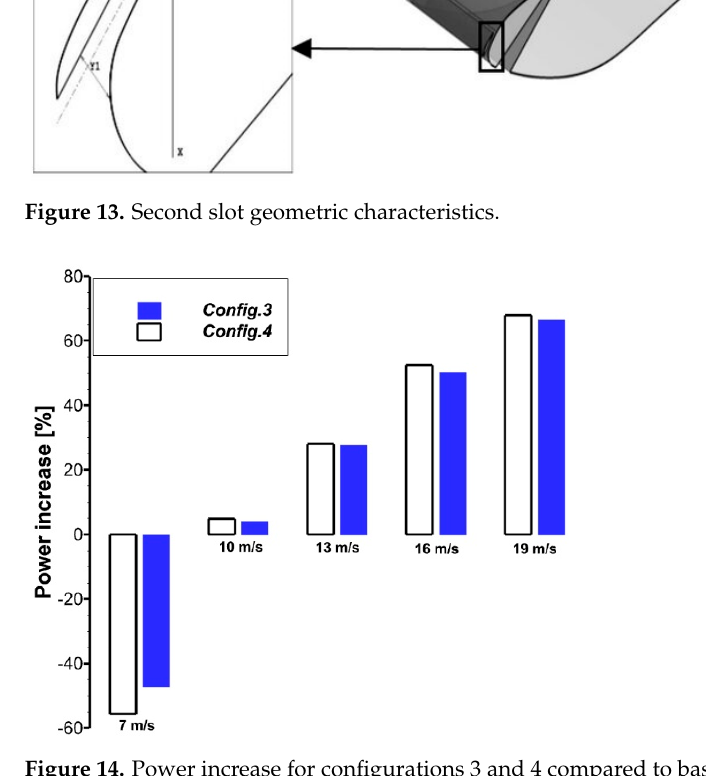
Figure 14. Power increase for configurations 3 and 4 compared to baseline.